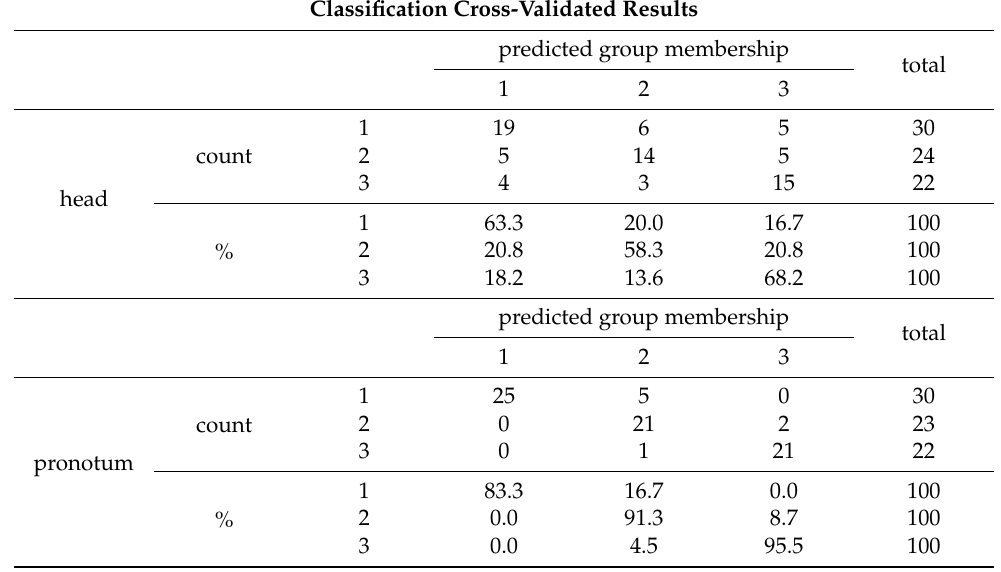
Canonical variate analysis (CVA) classification results for head and pronotum. The cross-validated values are given for each morph (1 = major males, 2 = females, 3 = minor males). For the head, 63.2% of the cross-validated grouped cases were correctly classified, and for the pronotum, 89.3% of the cross-validated grouped cases were correctly classified.